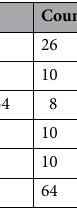
Table 7. Target count for each class in Leukemia_GSE9476.